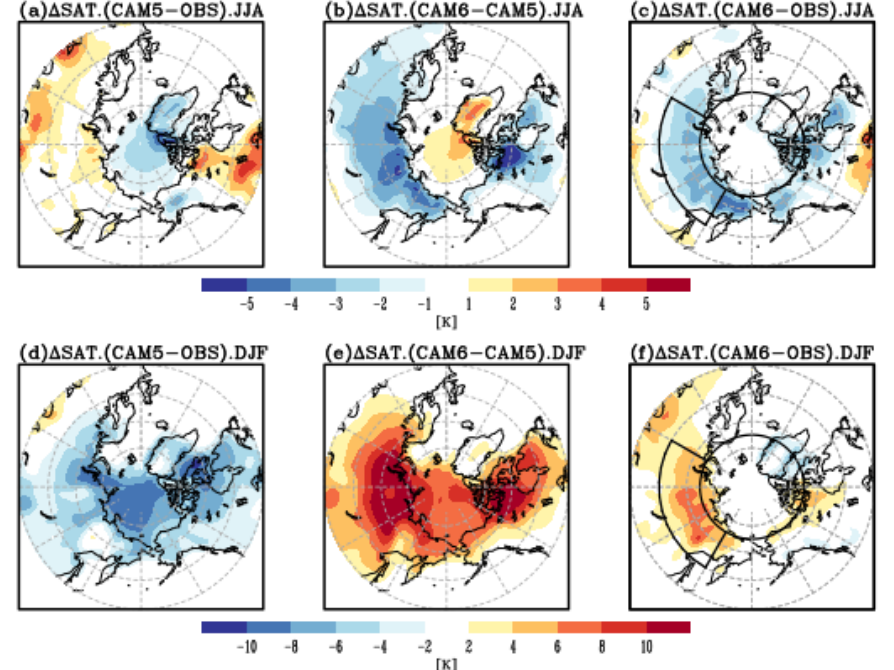
Figure 2. Biases of surface air temperature (SAT) against the ERA-Interim reanalysis during ( a – c ) JJA and ( d – f ) DJF obtained from ( left ) CAM5 and ( right ) CAM6, and ( center ) the differences in each variable between CAM6 and CAM5.